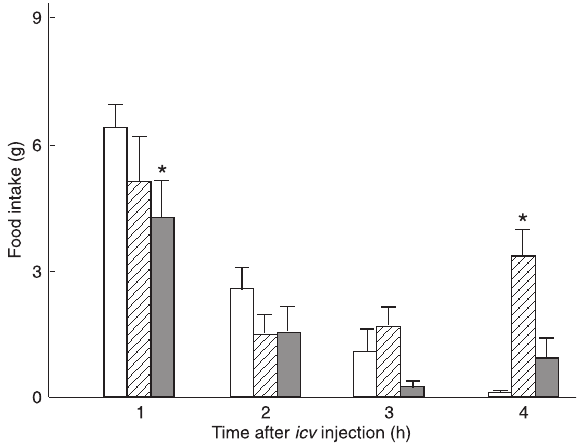
Figure 1. Effects of icv injection of BRL37344 [a β 3 -adrenergic receptor agonist at doses of 2 (striped bars) and 20 nmol (gray bars)] on food intake of 24-h fasted rats. Vehicle (saline) are open bars. Data are reported as means ± SEM. *P < 0.05 compared to